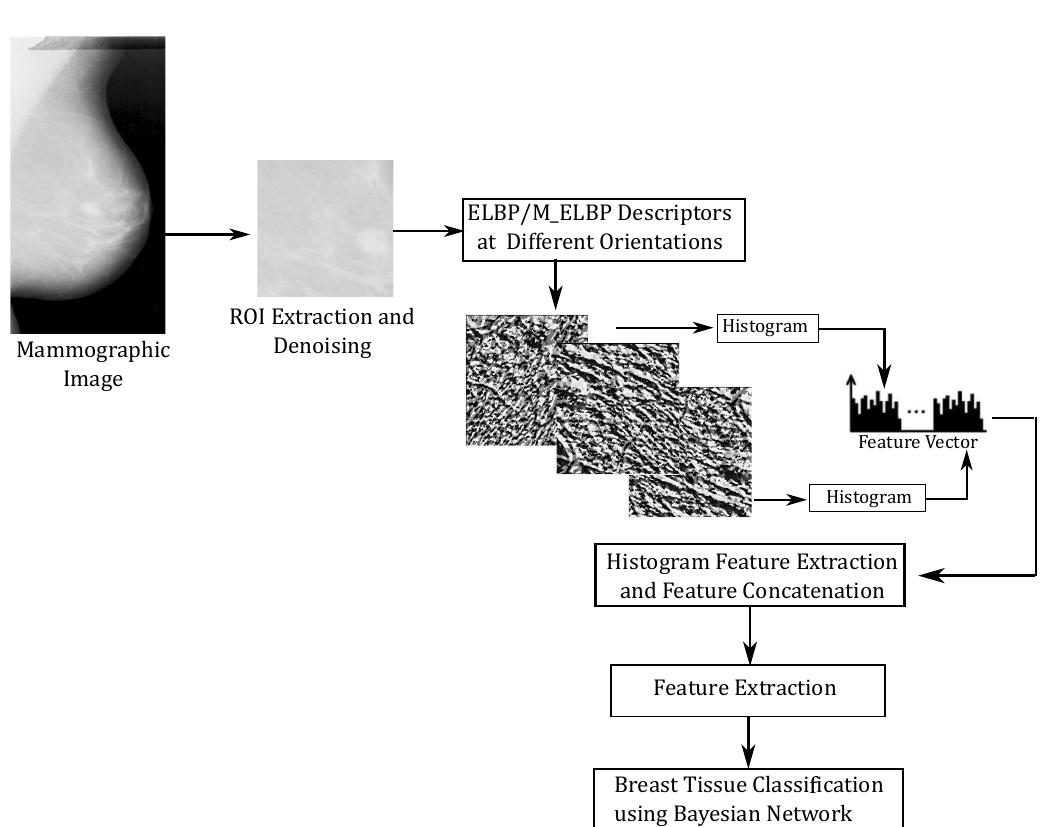
Figure 5. Summary of ROI selection, feature extraction and classification using ELBP